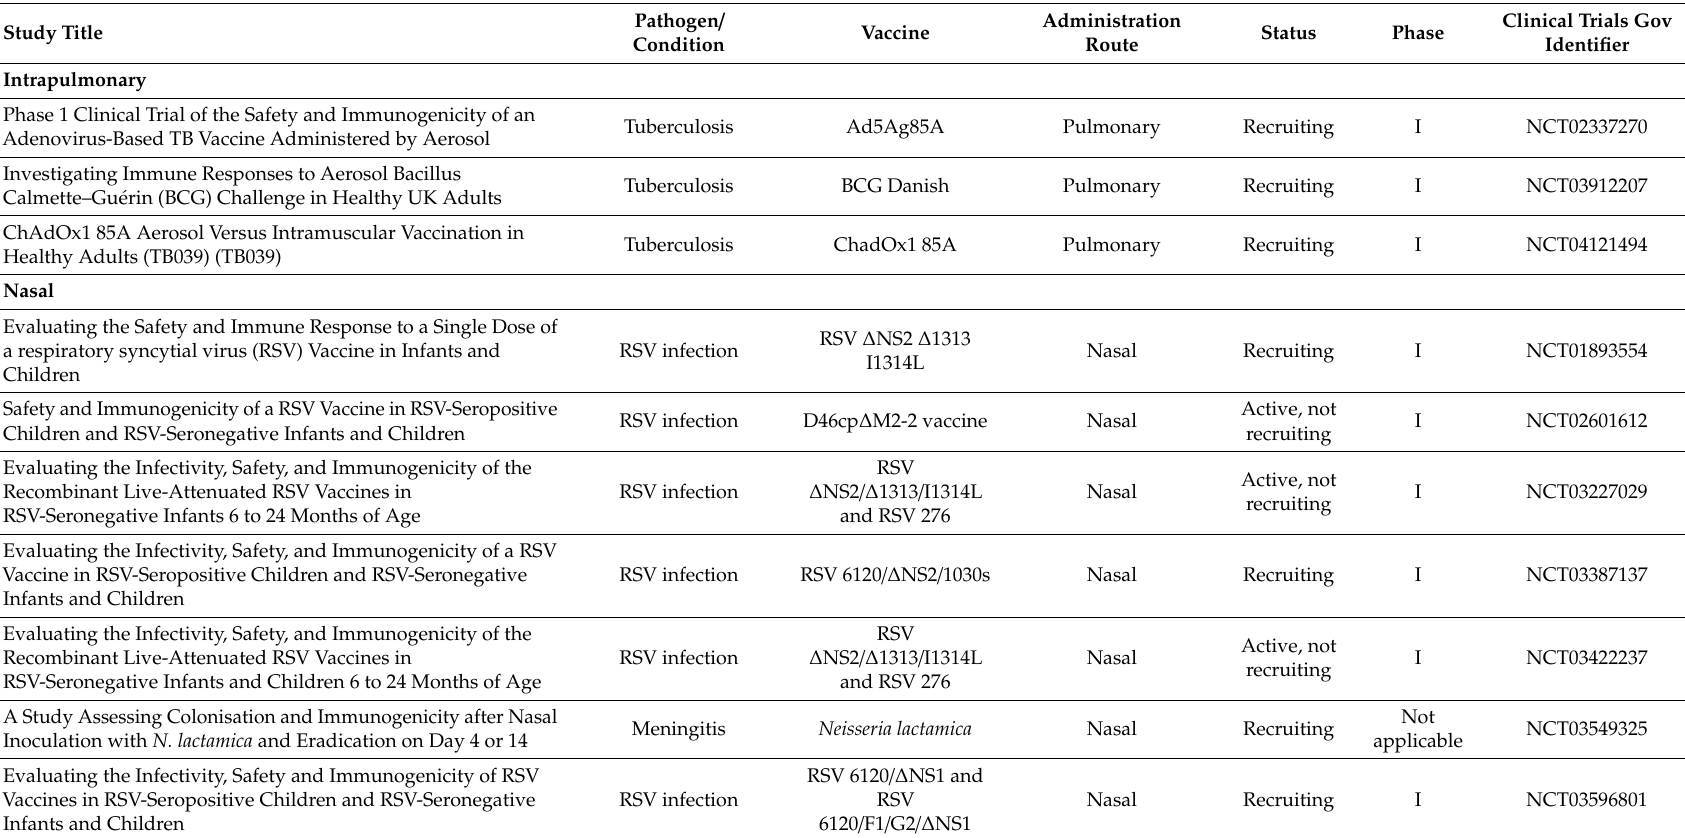
Table 1. Pulmonary and nasally delivered vaccines in clinical